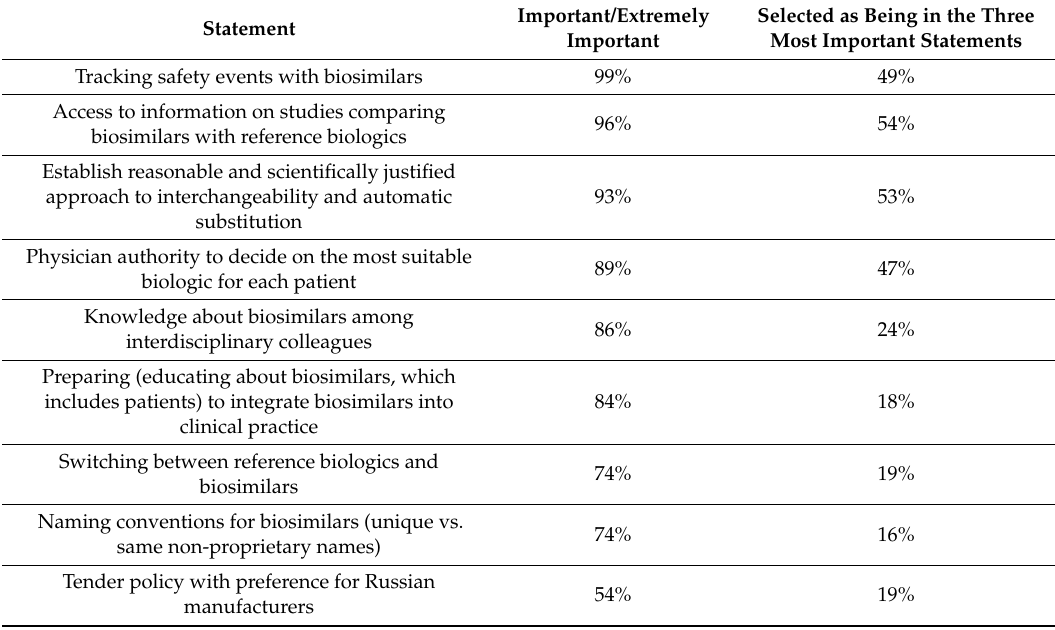
Table 3. The importance of issues related to biosimilars in professional environments ( n =